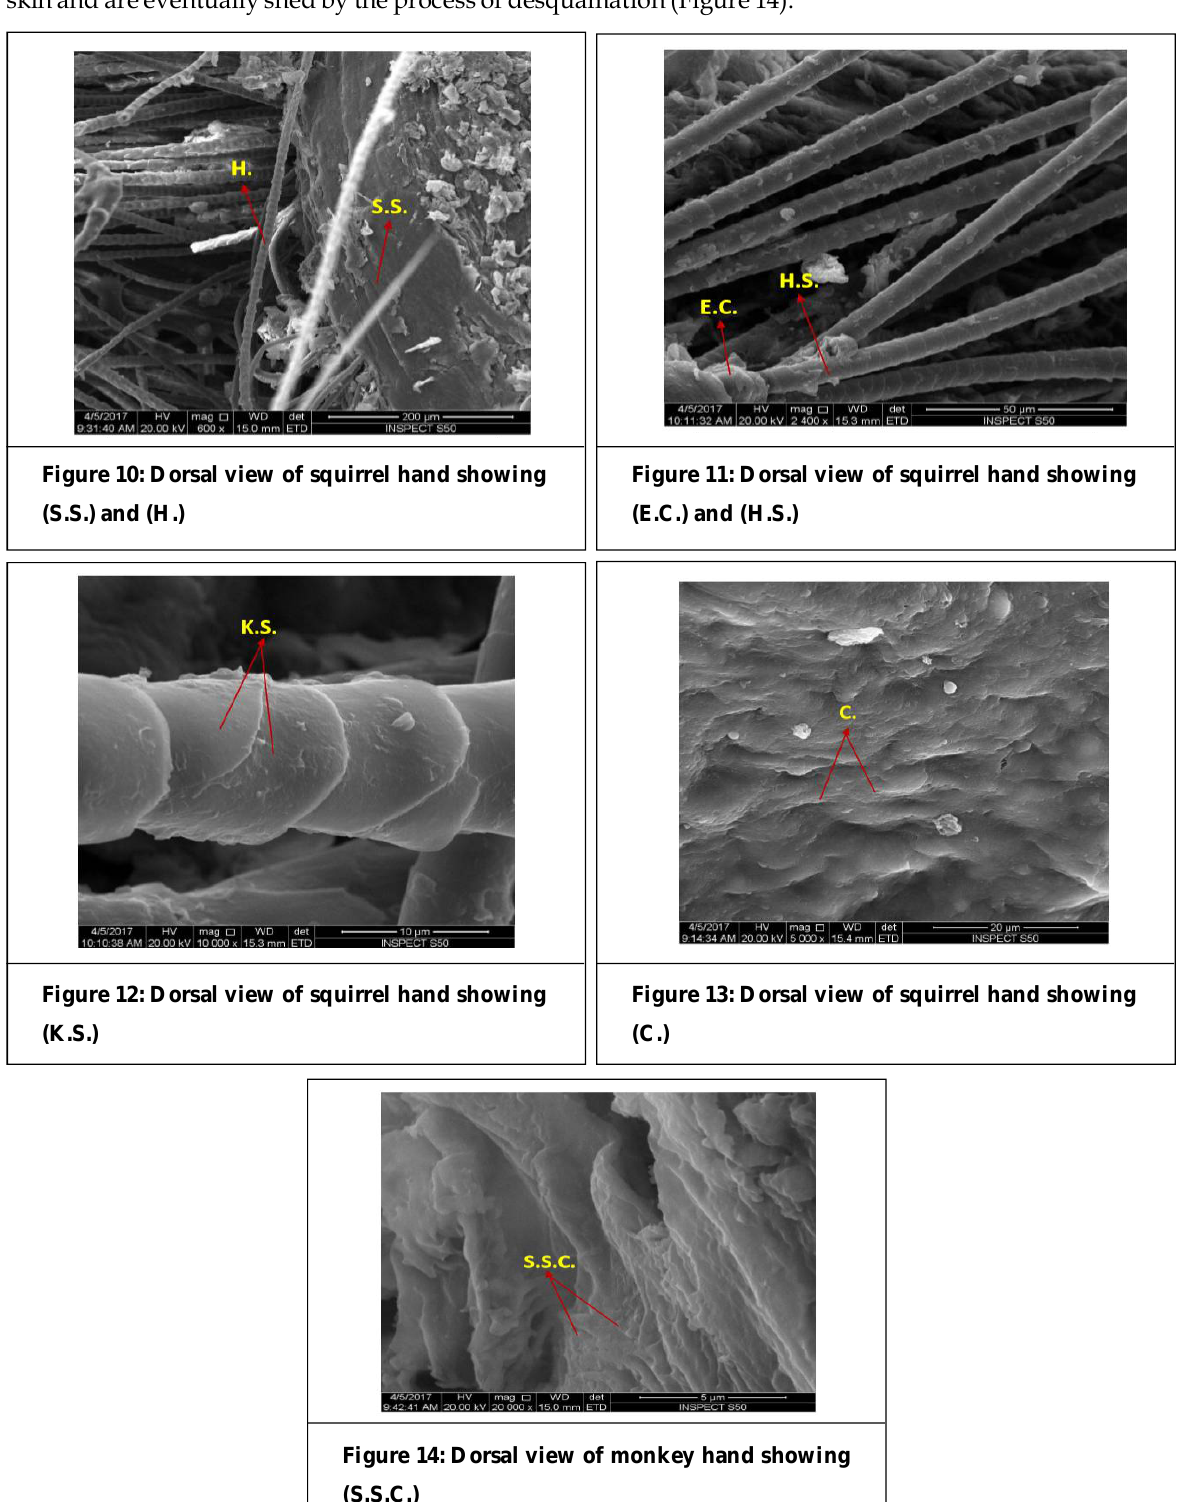
Figure 14: Dorsal view of monkey hand showing